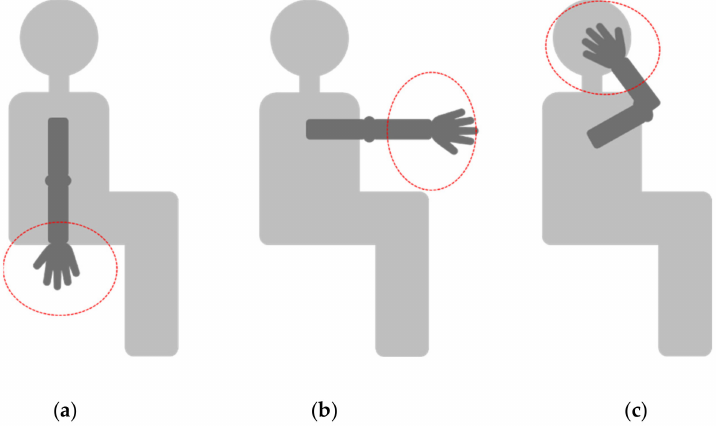
Figure 3. Upper arm end position classification. ( a ) Initial position. ( b ) Torso front. ( c ) Upper body nearby.